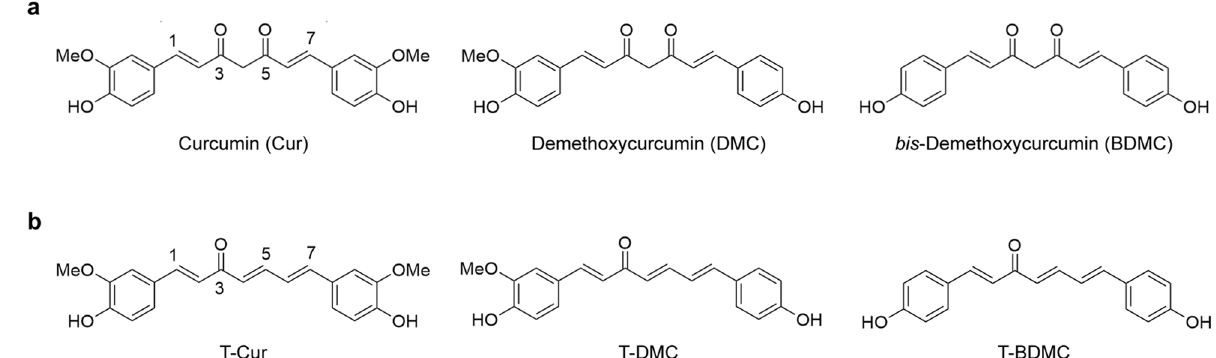
Figure 1. Structures of curcuminoids and trienone analogs of curcuminoids. ( a ) The structures of curcuminoids (Cur, DMC and BDMC) consist of two aromatic rings containing phenolic methoxy and/or hydroxy groups connected by an α,β-unsaturated β-diketo C 7 chain. ( b ) The structures of trienone analogs of curcuminoids (T-Cur, T-DMC and T-BDMC) consist of two aromatic rings containing phenolic methoxy and/ or hydroxy groups and the two aromatic rings are connected by a 1 E ,4 E ,6 E -heptatrien-3-one C 7